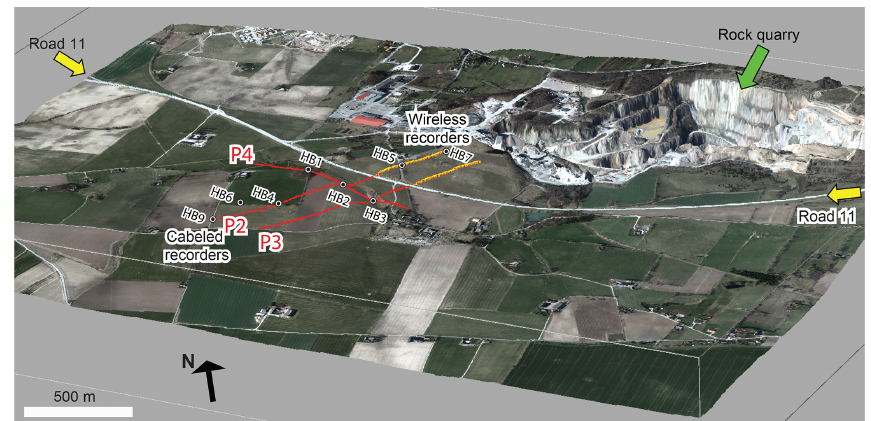
Figure 3. Locations of the seismic profiles (P2, P3 and P4), in Dalby (southern Sweden), draped onto the high-resolution lidar elevation surface of the study area. A combination of cabled and wireless recorders was used for the data acquisition to allow long-offset recording and to overcome issues related to the high-speed Road 11. Black filled-in circles are the drilled boreholes (after the seismic data acquisition) in the study